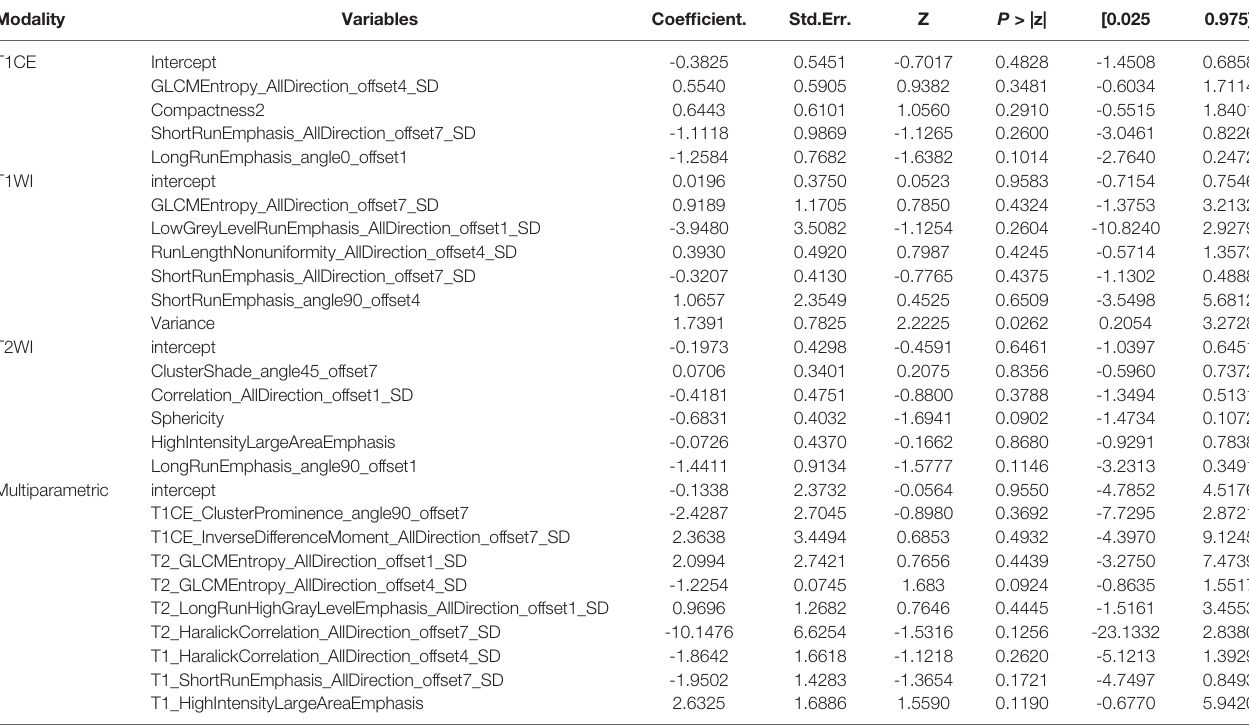
TABLE 3 | The screened features and their coef fi cients in the models for the different imaging sequences. Modality